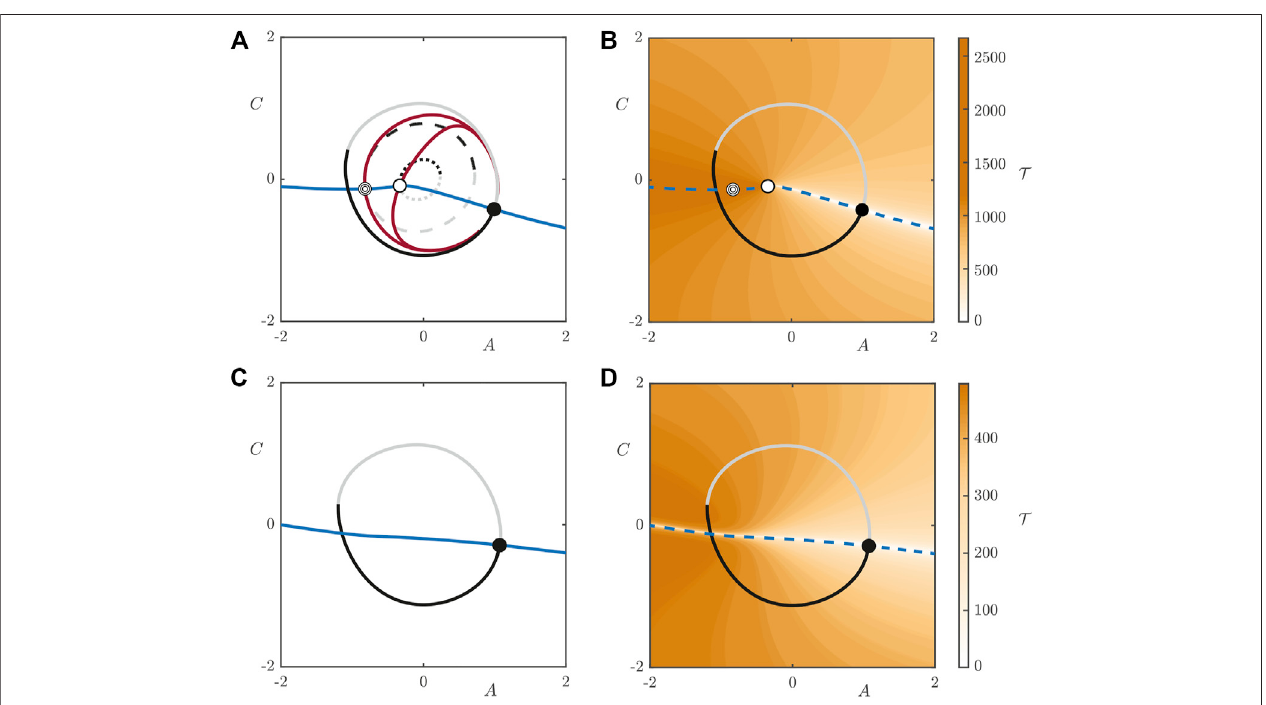
FIGURE9 | Intersections ofthe manifolds of theperiodic orbits of the 2D model with the plane ofzero phase for I (cid:1) 50[panels (A) + (B) ] and I (cid:1) 1000 [panels (C) + (D) ]. (A) + (C) :Manifoldsofthestableand saddleperiodicorbits [panel (A) ]andofthestable periodicorbit [panel (C) ].Stable andstrong stable manifoldsaredepictedin blue,whilstunstablemanifoldsarered.Alsoplottedaretheprojectionsontotheplaneofzerophaseofthestable(solidlines),saddle(dashedlines),andunstable(dotted lines)periodicorbitsinblackandgrey.Themarkersdenotethepointsofzerophasealongtherespectiveperiodicorbits. (B) + (D) :Heatmapsofentrainmenttimes, T , of trajectories with initial conditions distributed across the ( A , C ) plane. The dashed blue lines are the strong stable manifolds of the stable periodic orbit [panels (B) + (D) ] and the stable manifold of the saddle periodic orbit [panel (B)